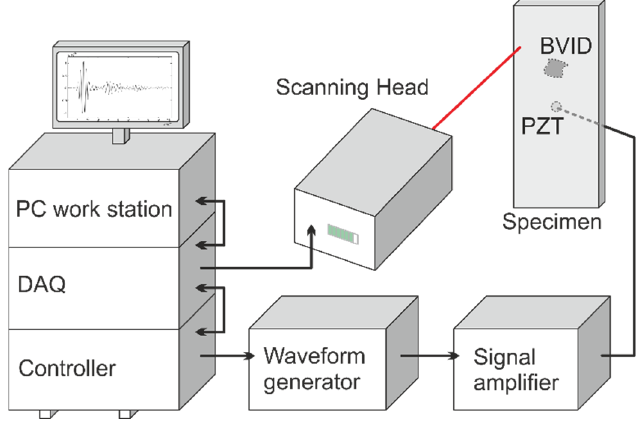
Figure 9. Experimental set-up diagram.